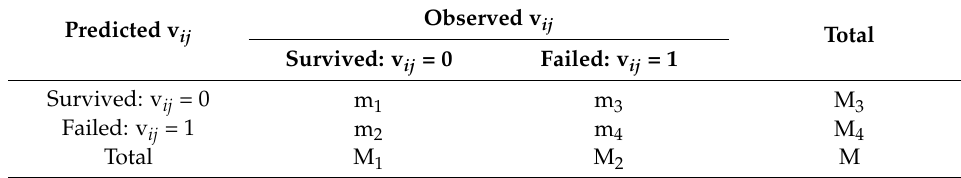
Table 2. Classification table for a discrete hazard